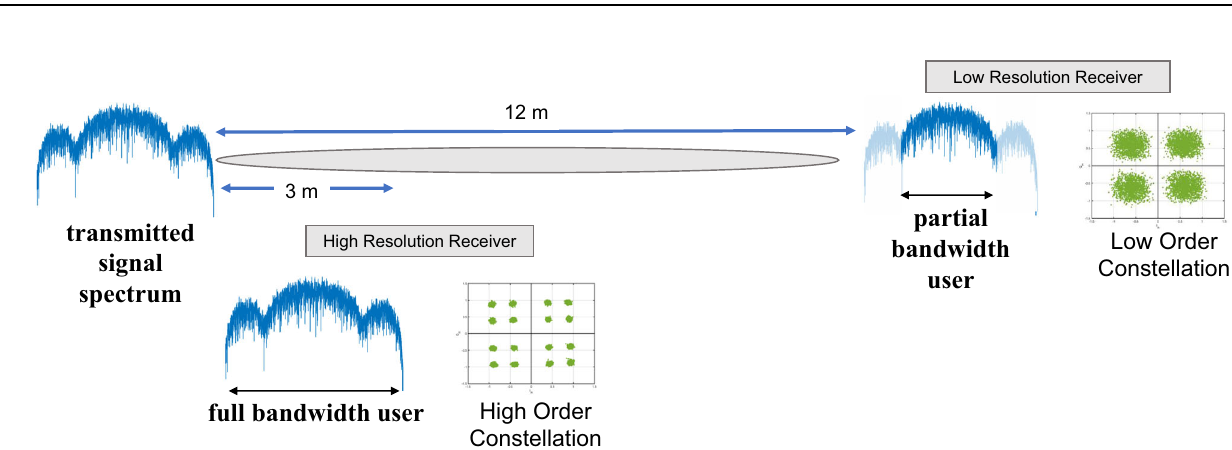
Fig. 4 | Hierarchical bandwidth modulation. Leveraging the spectral fi ltering effect of atmospheric water vapor absorption resonances to implement hier- archical bandwidth modulation, in which nearby users can access the full